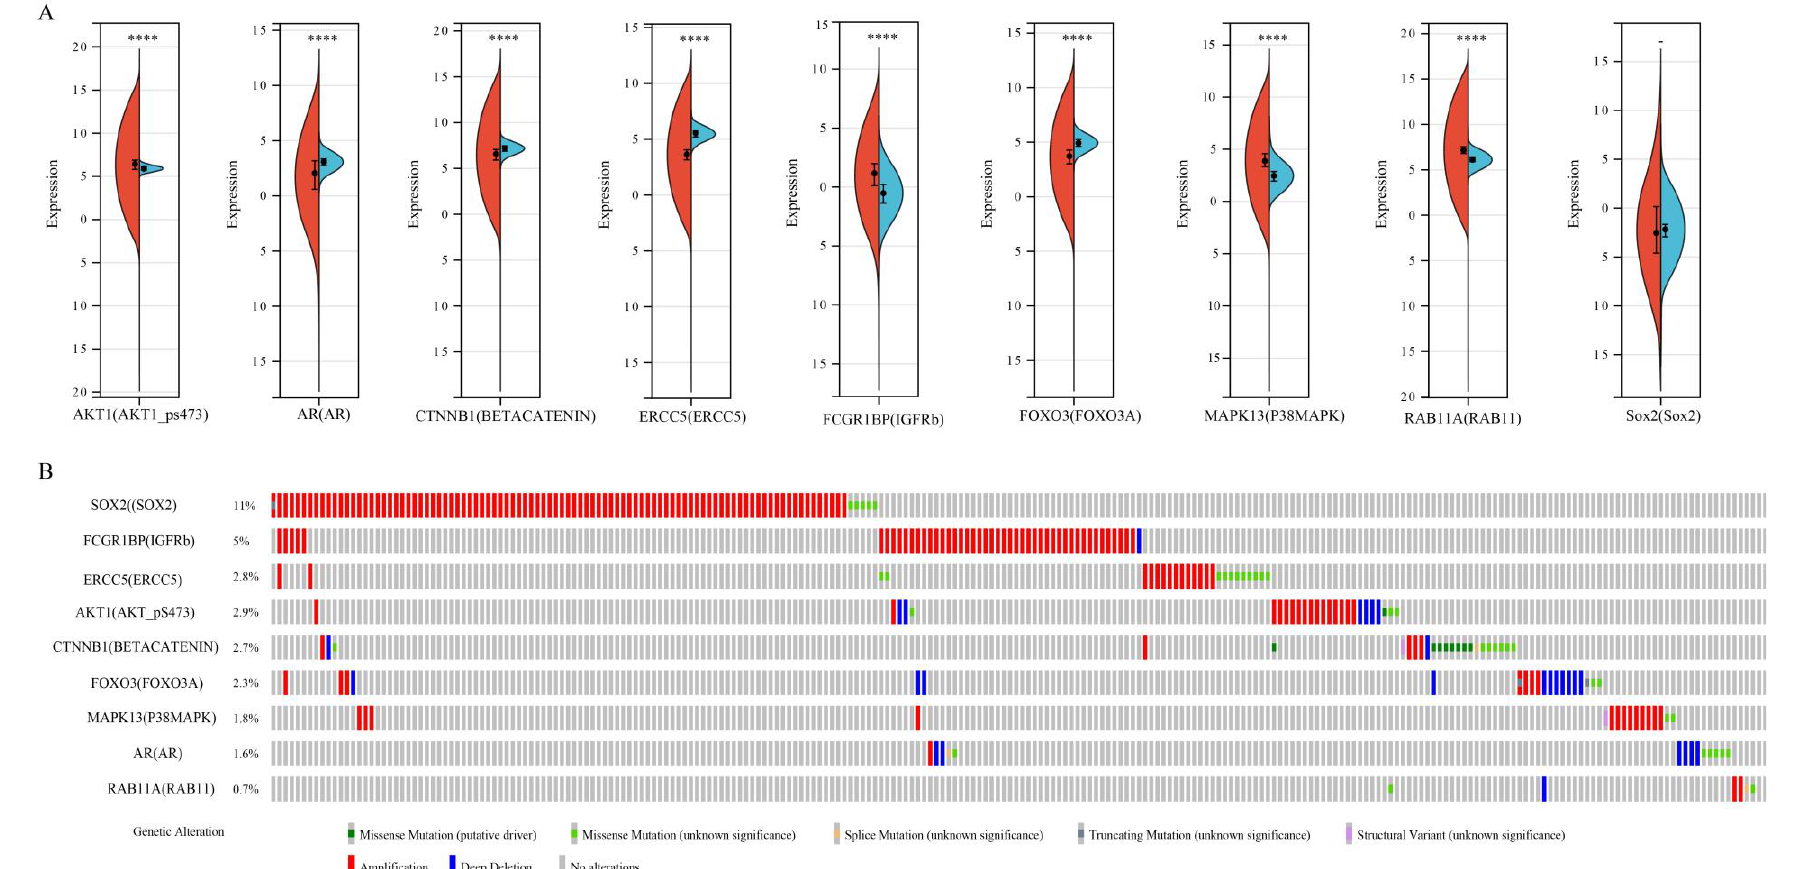
Figure 11. Analysis of protein-coding genes. ( A ) Expression of protein-coding genes between ovarian cancer and normal tissues in Sangerbox. ( B ) The mutation of protein-coding genes in cBioPortal database (**** p < 0.0001).